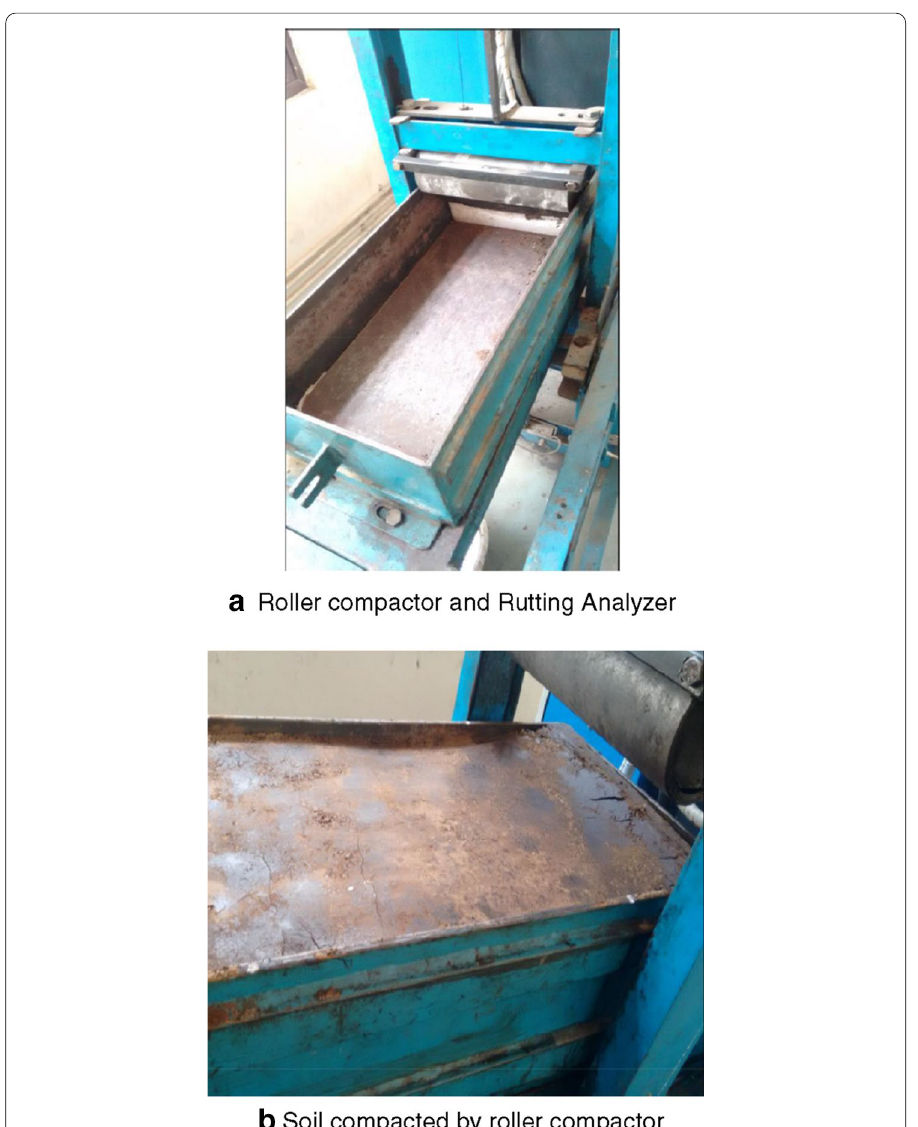
Fig. 1 a Roller compactor and Rutting Analyzer. b Soil compacted by roller